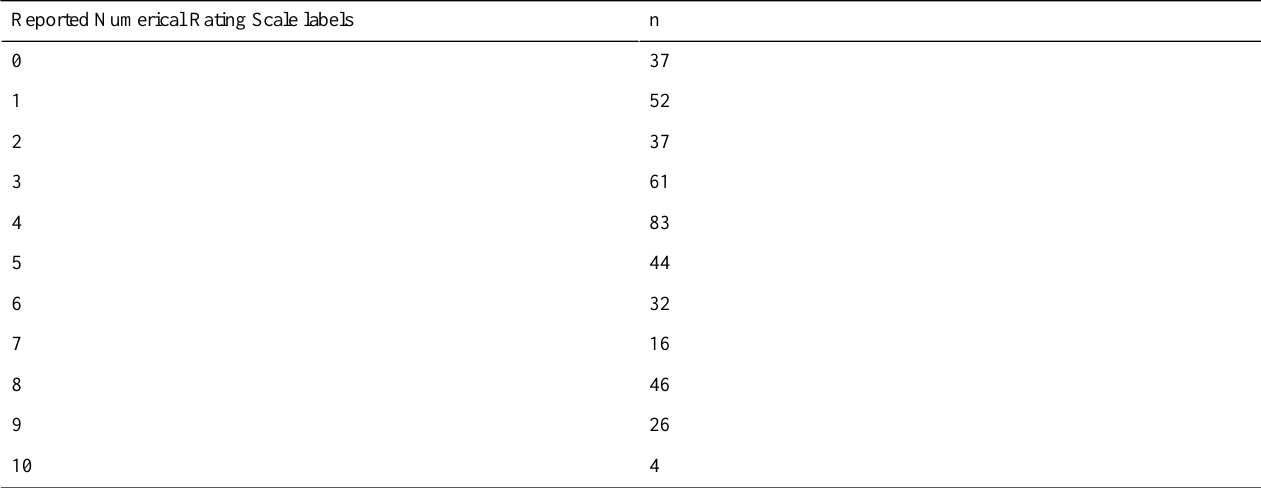
Table 3. Numerical Rating Scale distribution for 11 pain classes.